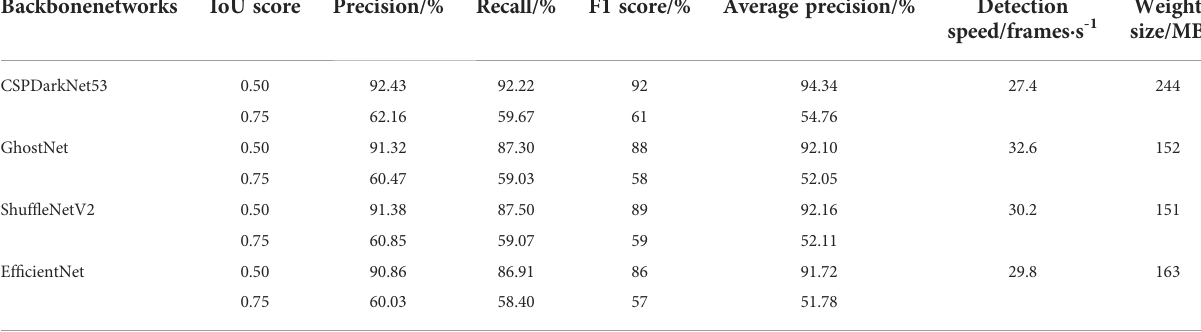
TABLE 1 Comparison results of detection performance of different backbone networks.